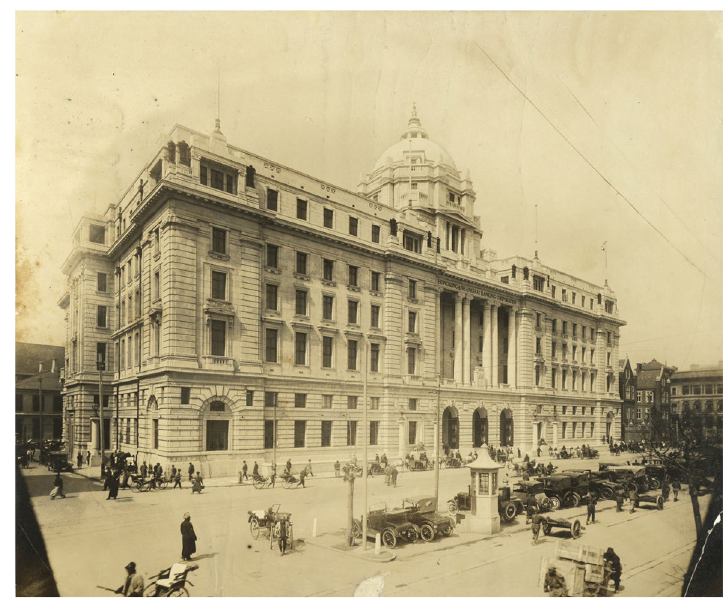
Fig. 2 The former HSBC Building shortly after opening in 1923. (Source: reproduced with the permission of HSBC Holdings